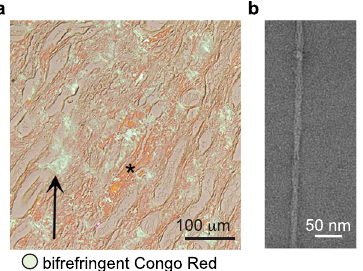
Fig. 1 | AA amyloid extracted post-mortem from the kidney of a shelter cat deceased with renal failure. a Abundant interstitial Congo Red-stained amyloid deposits appear orange-red (asterisks) with green-apple birefringence (arrows) under polarized light. b Micrograph of negative-stained fi bril extracted from the kidney. See Supplementary Figs. 1 and